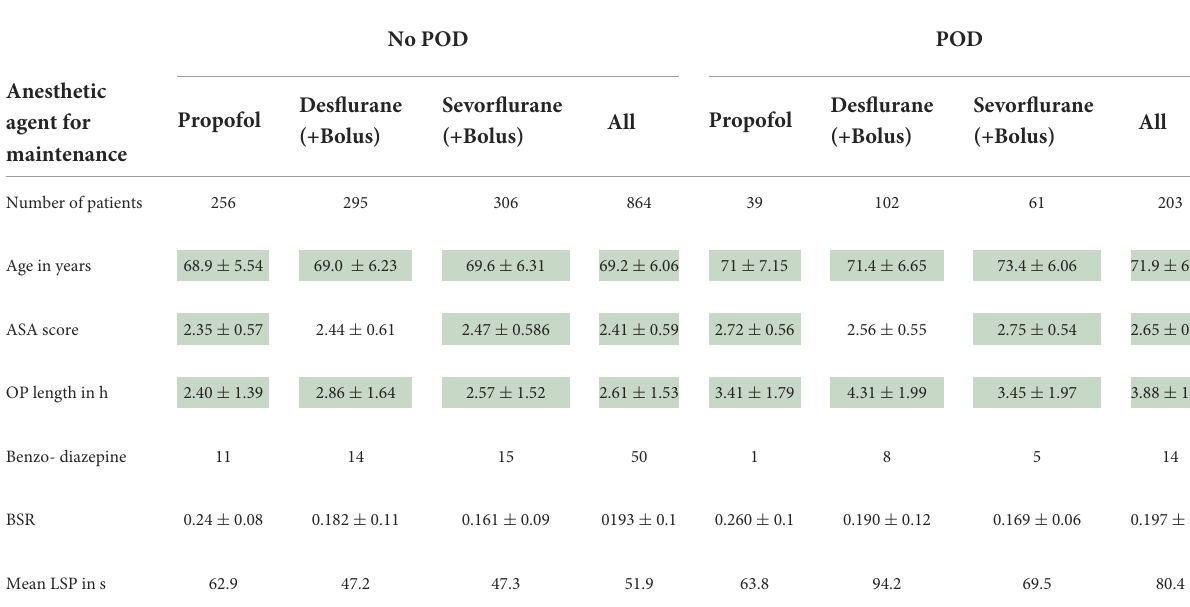
TABLE 1 Overview SuDoCo